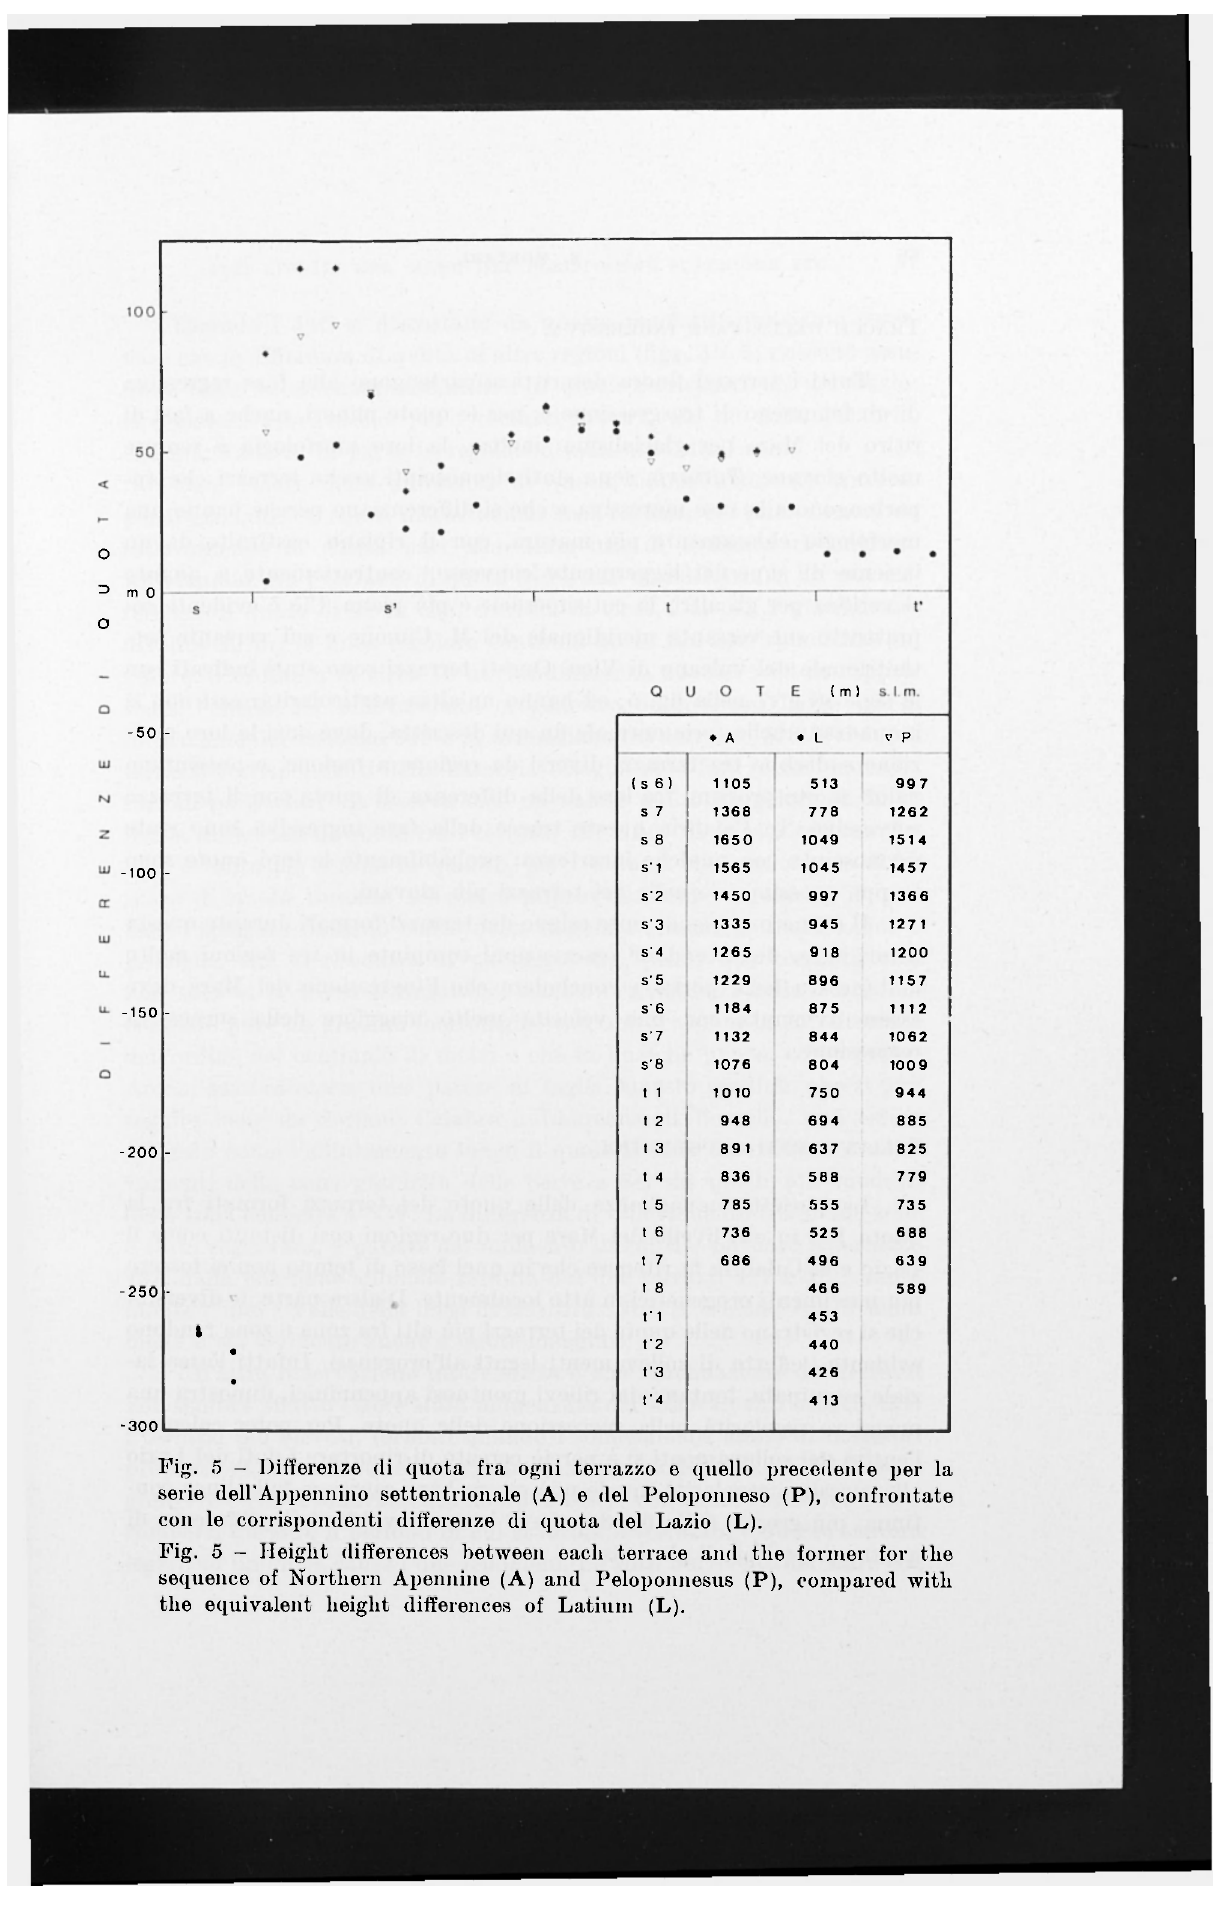
Fig. 5 - Differenze di quota fra ogni terrazzo e quello precedente per la serie dell'Appennino settentrionale (A) e del Peloponneso (P), confrontate con le corrispondenti differenze di quota del Lazio (L). Fig. 5 - Height differences between each terrace and the former for the sequence of Northern Apennine (A) and Peloponnesus (P), compared with the equivalent height differences of Latium